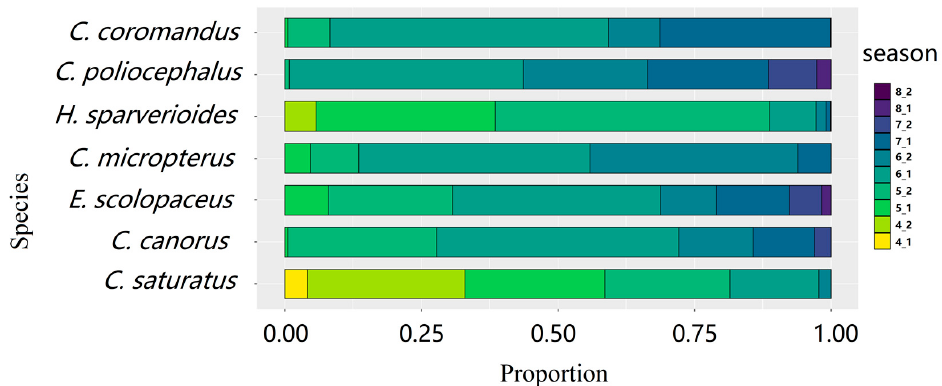
Figure 3. Seasonal distribution of calling activity of the different species during the year. Each group is represented by the half-month’s relative percentage of presence per species. The longer the rectangle, the more likely the presence of the species in this half-month is.